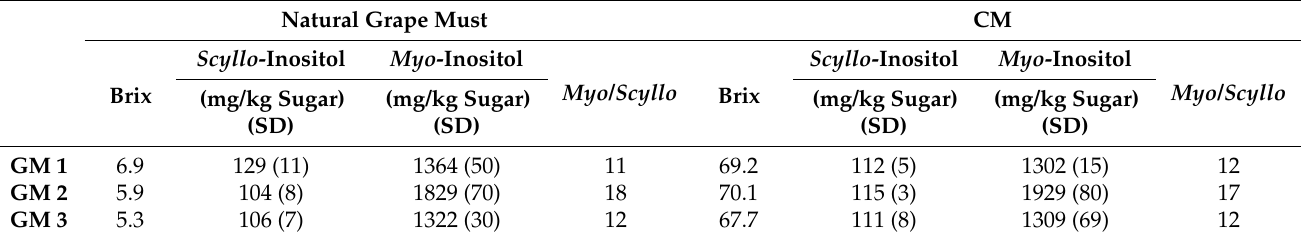
Table 2. Means of myo - and scyllo -inositol content in natural grape must and corresponding concen- trate (CM); values in brackets refer to standard